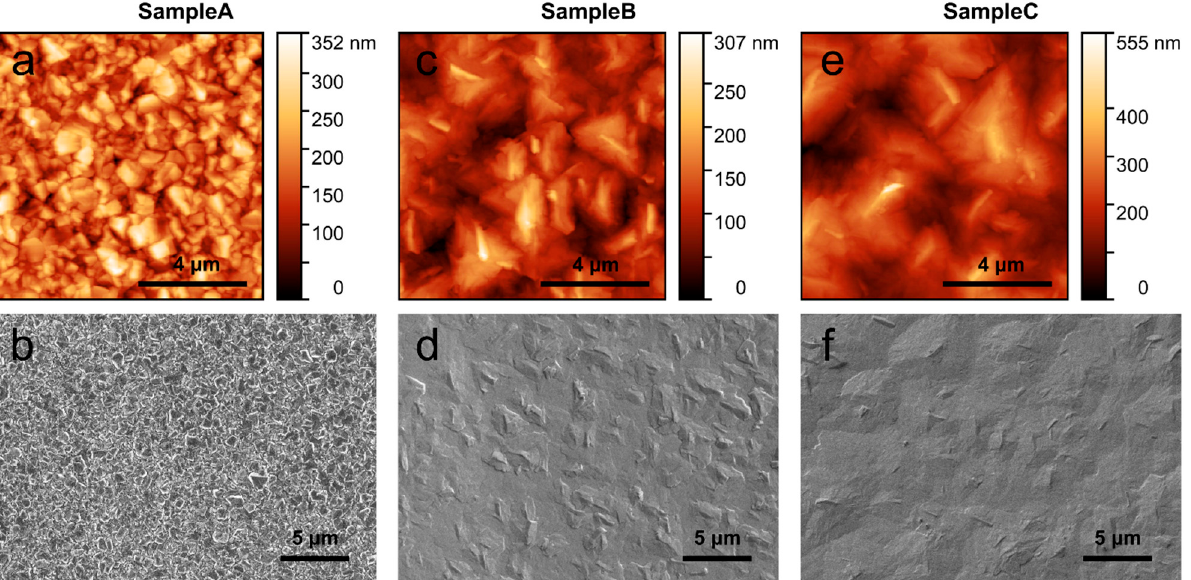
Figure 2. Atomic force microscopy (10 µ m × 10 µ m scans) and scanning electron microscopy images of ( a , b ) Sample A, ( c , d ) Sample B and ( e , f ) Sample C, respectively, showing the surface morphology of the as-grown Ga 2 O 3 films.